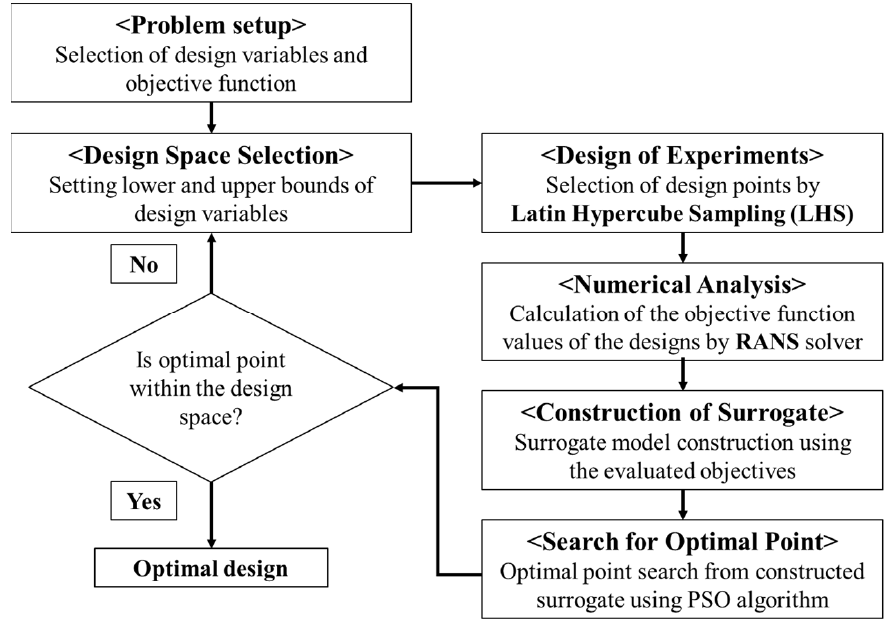
Figure 4. Single-objective optimization process.